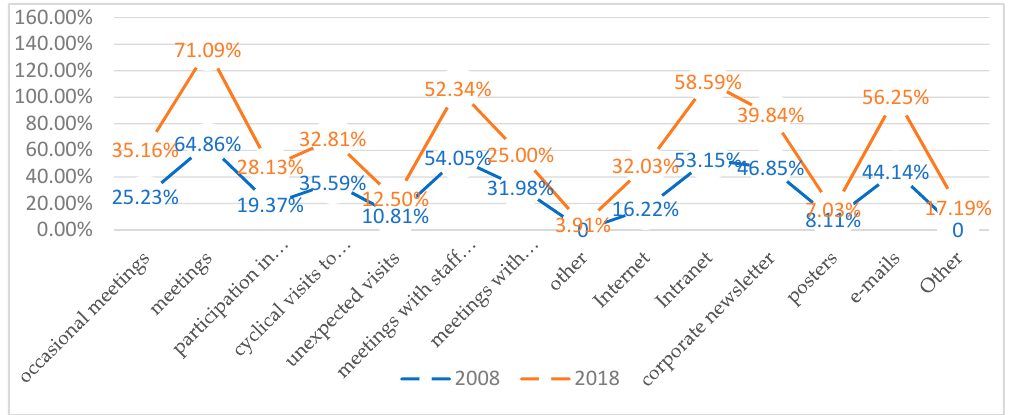
Figure 1. The effectiveness evaluation of a leader’s vision-transfer methods in the opinion of leaders of the Forbes Global 2000 world’s largest corporations.